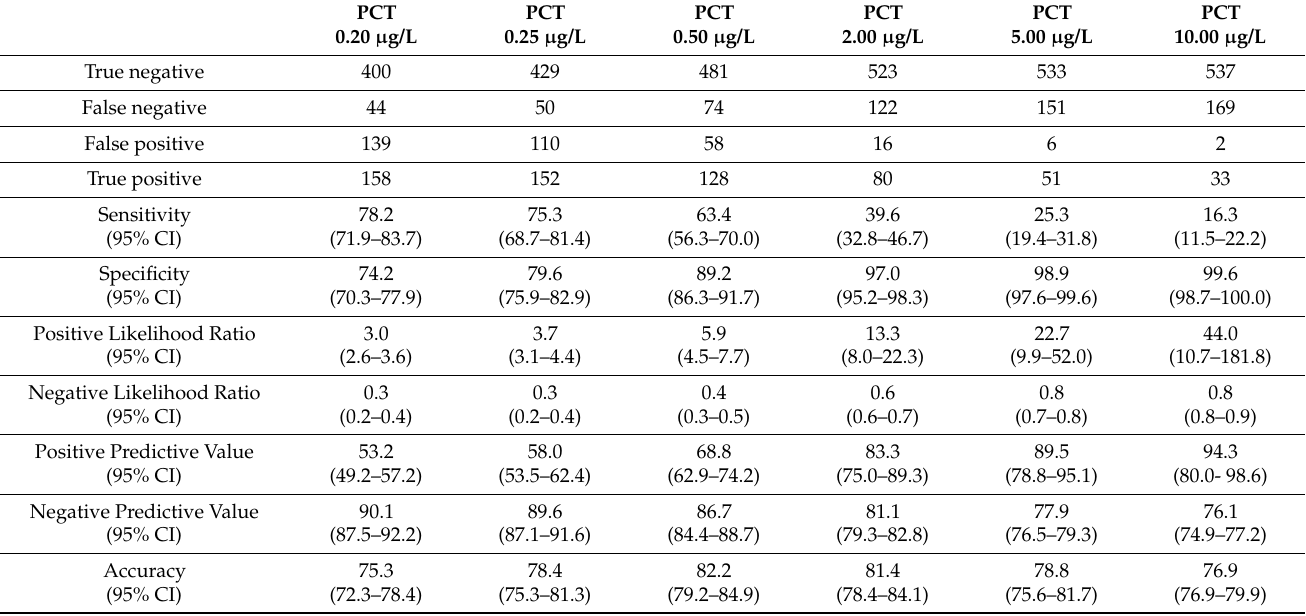
Table 2. Diagnostic performance of PCT at different cut-off values (recommended by the manufacturer) for the diagnosis of sepsis within 96 h of admission.